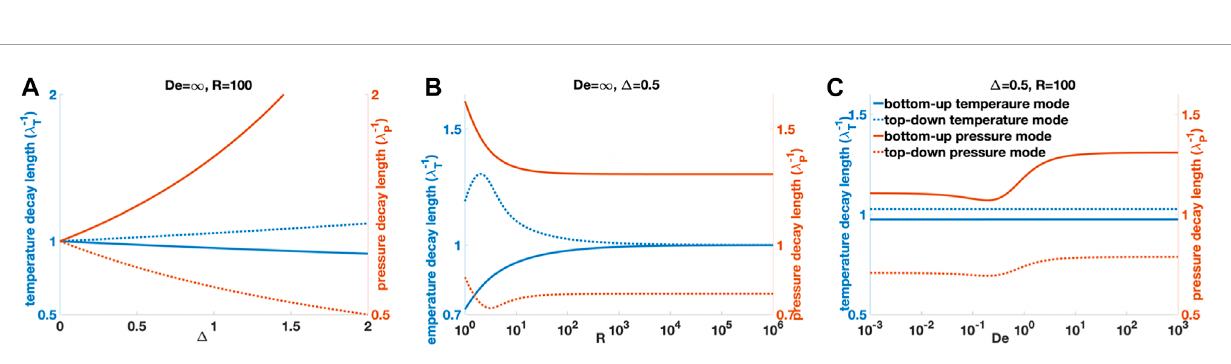
FIGURE 4 Decay length 1 /| Re ( k )| for all solutions for (6) shown as functions of dimensionless parameters. The decay lengths associated with thermal modes are normalized by the thermal skin depth (left y -axis, blue curves). The decay lengths associated with pressure modes are normalized by the poroelastic skin depth (right y -axis, red curves). Solid lines are decay lengths for bottom-up sub-waves (i.e., against the background thermal gradient); dash lines are decay lengths for top-down sub-waves (i.e., along the background thermal gradient). (A) Shows the decay lengths as functions of Δ which reflects the extent of thermal-mechanical coupling; (B) shows the decay lengths as functions of R, the ratio between poroelastic diffusivity and thermal diffusivity; (C) shows the decay lengths as functions of Deborah number De . When R = ∞ , De = ∞ , Δ = 0, the system recovers pressure diffusion endmembers with no viscoelastic relaxation, no thermal diffusion, and no thermo-mechanical coupling.